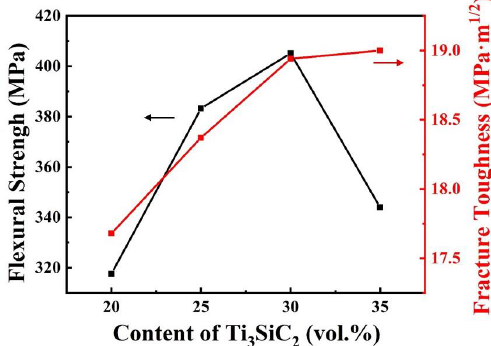
Figure 6. Flexural strength and fracture toughness of the B 4 C–TiB 2 composite ceramics sintered with different contents of Ti 3 SiC 2 . Materials 2020 , 13 , x FOR PEER REVIEW